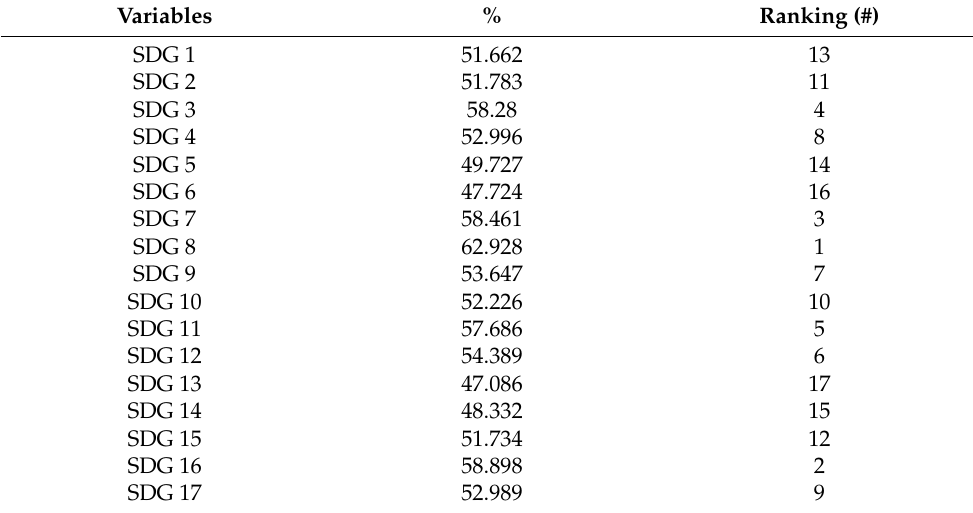
Table 6. Descriptive statistics for SDG